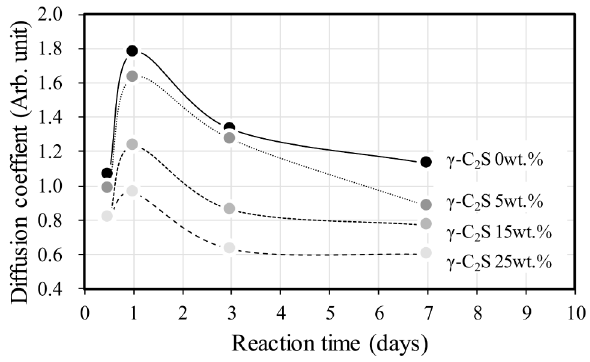
Figure 9. Diffusion coefficients of specimens from measurements Figure 9. Di ff usion coe ffi cients of specimens from measurements taken.